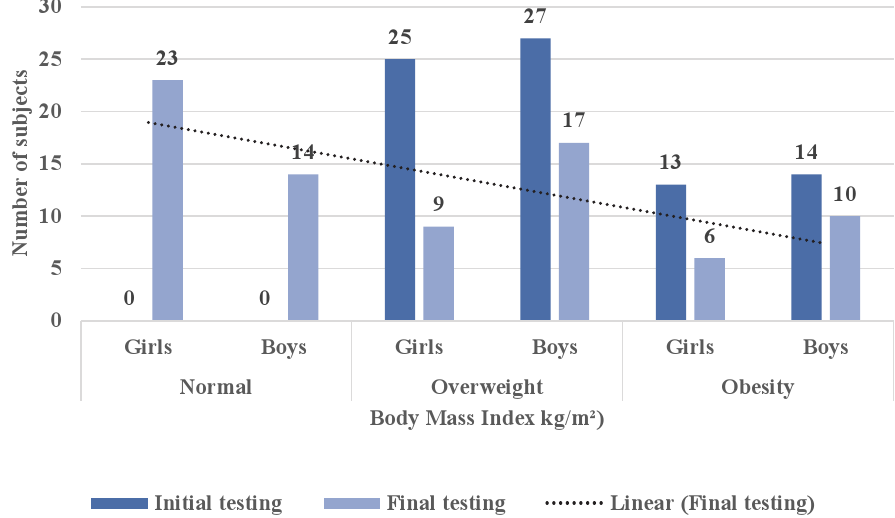
Figure 8. Distribution of initial and final body mass indices for the target sample by gender.